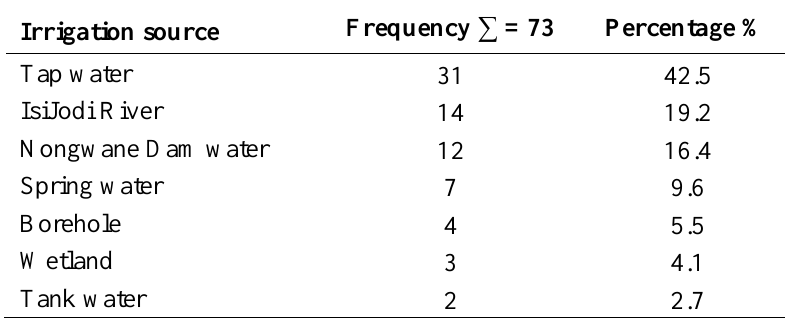
Table 1. Irrigation water sources in descending order as identified by the